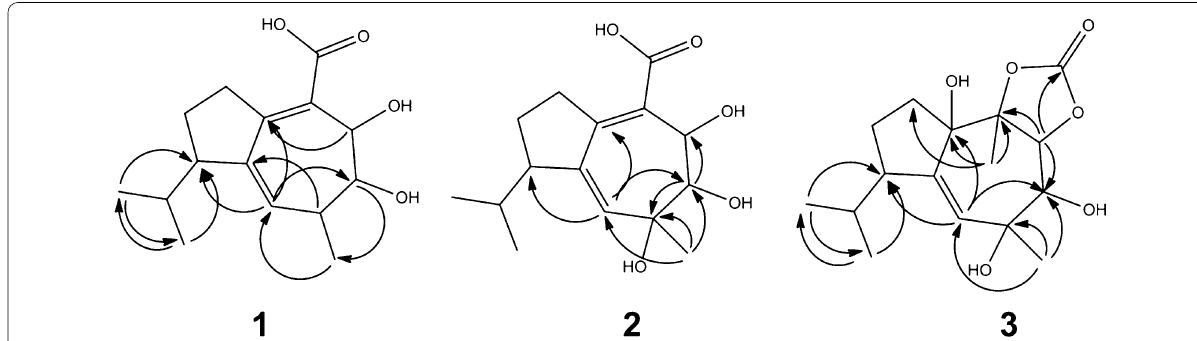
Fig. 3 Key HMBC correlations of Taiwania A ( 1 ), Taiwania B ( 2 ), and Taiwania C ( 3 )